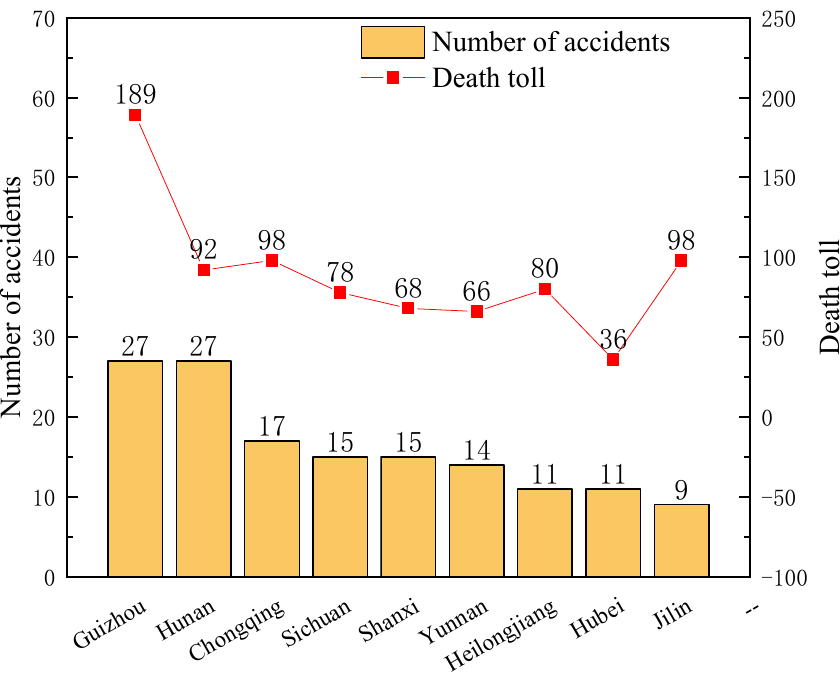
ff erent provinces from 2013 to